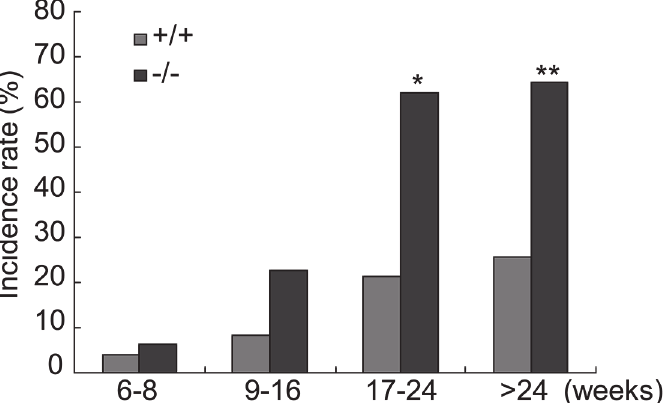
Fig 2. Lgr4 deletion leads to the early onset of age-related cataract. At the age of 6 to 8 weeks (wild-type: n = 24; Lgr4 − / − : n = 16), Lgr4 − / − mice showed no increased incidence of cataract formation. In the second stage (9 to 16 weeks, wild-type: n = 36; Lgr4 − / − : n = 22), the incidence of cataract formation was increased in Lgr4 − / − mice. The incidence of cataracts in Lgr4 − / − mice was significantly increased by maturity (17 to 24 weeks, wild-type: n = 42; Lgr4 − / − : n = 29) and older than 24 weeks (wild-type: n = 62; Lgr4 − / − : n = 45). * P < 0.001, ** P < 0.0001.